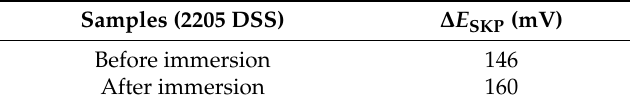
Table 3. Surface potential variation range in SKP mapping.